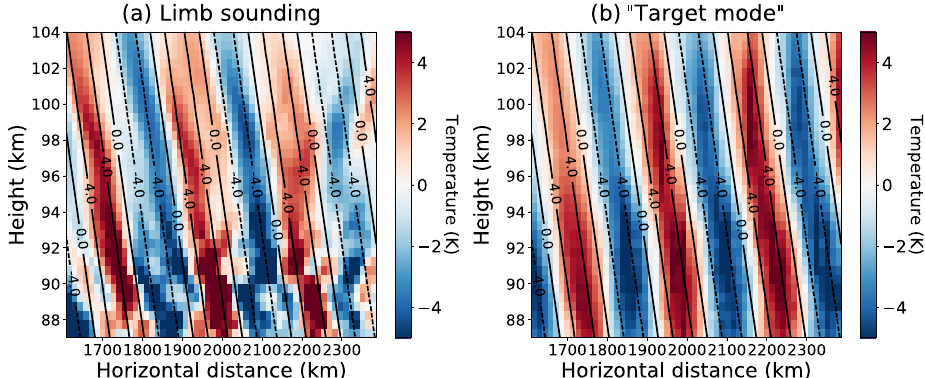
Figure 10. Pure limb sounding (a) and “target mode” (b) retrieval results comparison. The GW has a wavelength of 250km in the horizontal and 40km in the vertical. The climatological background profile was subtracted from the retrieval result. The black lines indicate the true modulated wave